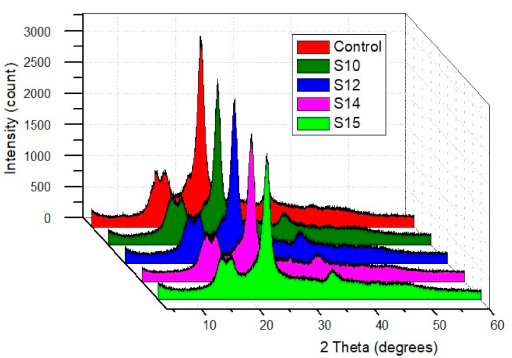
Figure 6. Differential scanning calorimetry (DSC) of control sample and some treated samples (S10, S12, S14 and